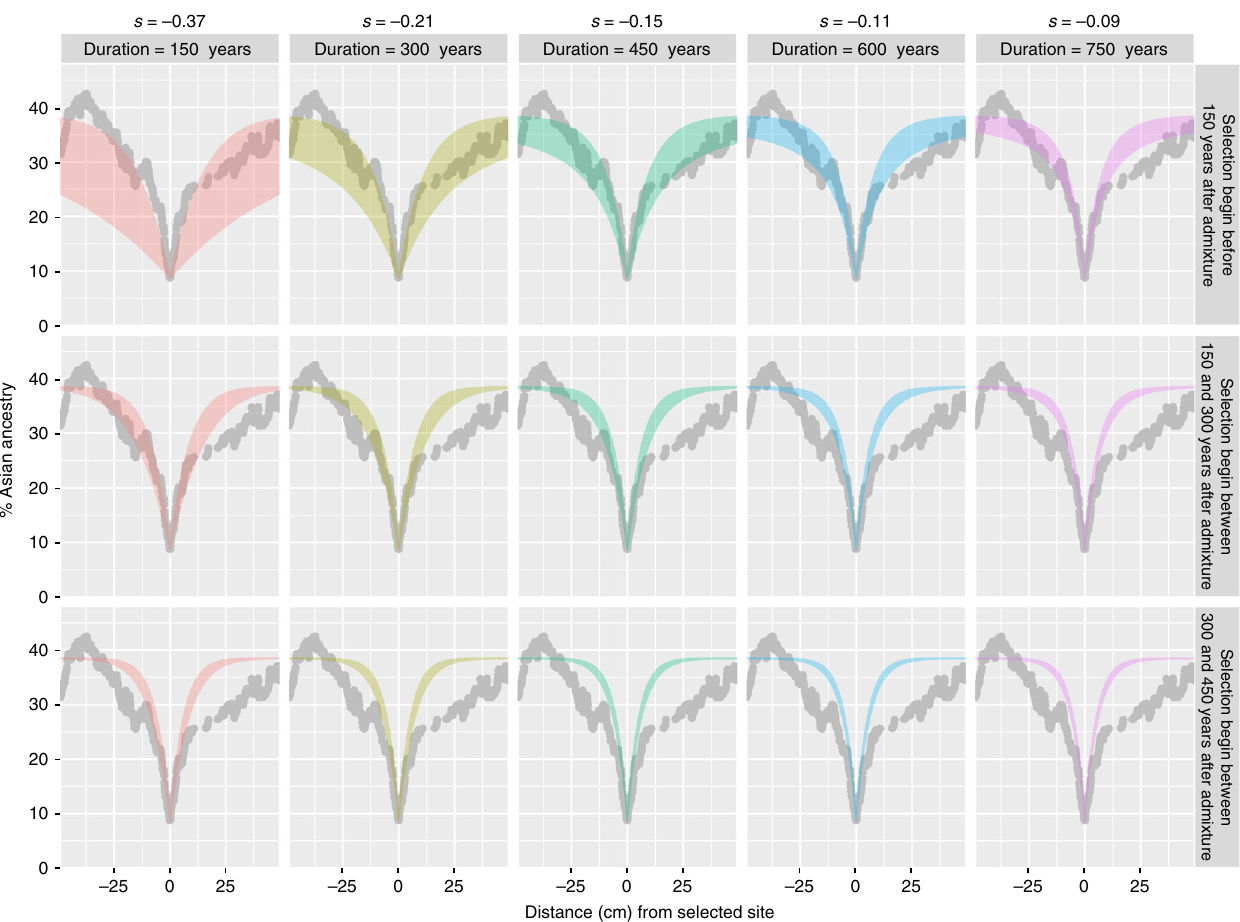
Fig. 4 Change in local ancestry expected around a site under selection computed for various times of selection and selection coef fi cients. The gray dots represent the actual data for Asian ancestry observed around the position rs12705 ( ACKR1 gene), the colored bars are the expected values for the indicated selection coef fi cient, the interval between the onset of admixture and the onset of selection, and the duration of